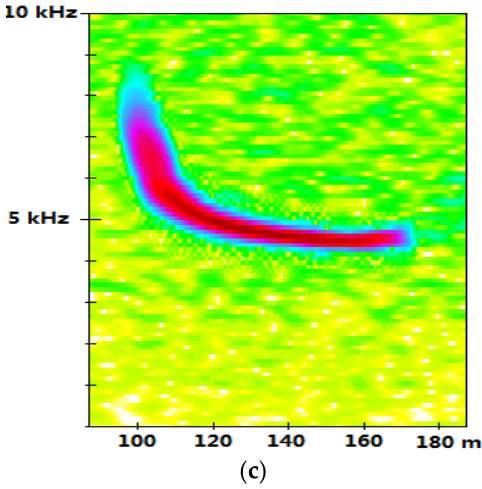
Figure 1. ( a ) Waveforms from LIGO sites [2] and their location and sonograms. Figure from https://losc.ligo.org/events/GW150914/. The gravitational-wave event GW150914 observed by the LIGO Hanford (H1, left column panels) and Livingston (L1, right column panels) detectors. Times are shown relative to 14 September 2015 at 09:50:45 UTC. For visualization, all time series are filtered with a 35–350 Hz band-pass filter to suppress large fluctuations outside the detectors’ most sensitive frequency band, and band-reject filters to remove the strong instrumental spectral lines; ( b ) Chirping Sparrow (Spizella passerina) song: frequency versus time (in seconds), showing a song made up of a series of chirps; ( c ) A Pipistrelle bat call for echolocation. Bats use ultrasound for “seeing” and for social calls. This spectrogram is a graphic representation of frequencies against time. The color represents the loudness of each frequency. This spectrogram shows a falling call, which becomes a steady note. The yellow and green blotches are noise. This is nearly a time reverse of black hole merger sonograms.